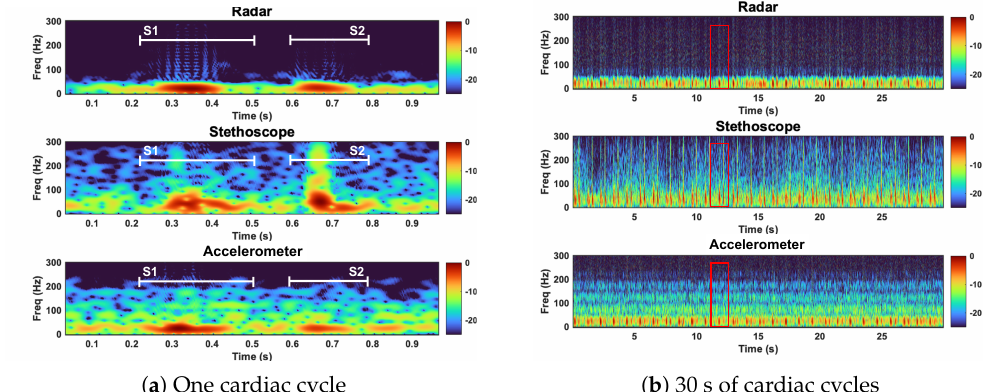
Figure 13. Spectrogram of the radar, stethoscope, and accelerometer measurement techniques. Plot ( a ) depicts a close up of one cardiac cycle, circled in red in plot ( b ). All three measurements capture the low − frequency components of the heart sounds. The stethoscope captures high − frequency heart sound